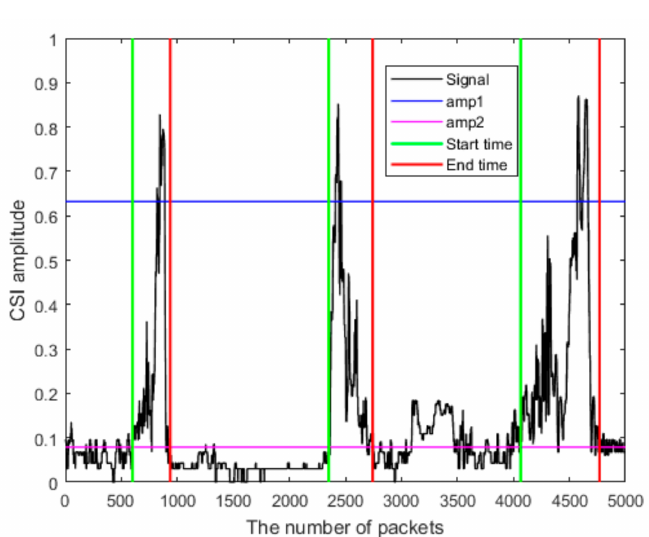
Figure 5. Determination of the start and end times of entering or